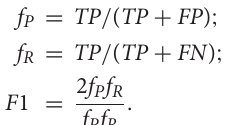
number of spindle events in source vs. sensor space and (ii) score of detected spindle events in source vs. sensor space. We defined temporal overlap as ≥ 20% [ F1 scores for different overlap values (10–50%) and window lengths (0.4–2 s) are presented in Supplementary Figure 2 ]. Spindle event density in source